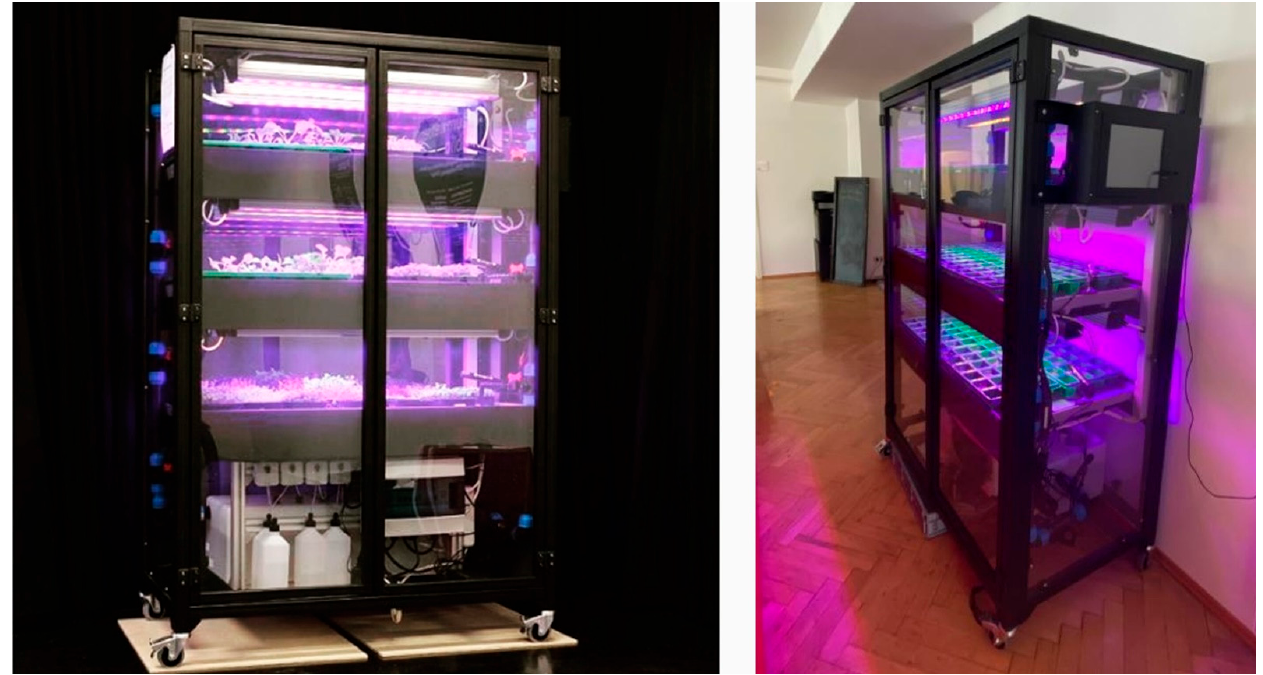
Figure 1. Smart Office Farm (Photos: Farmee GmbH, 2020 ( left ) and Cichocki, 2020 ( right )).